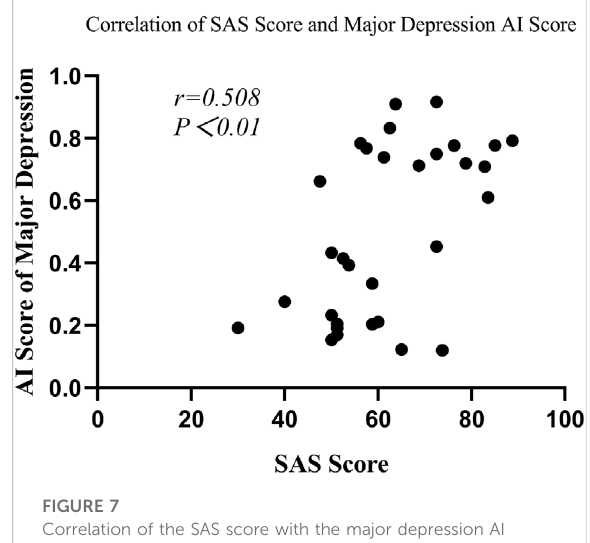
FIGURE 6 Correlation of the SDS score with the major depression AI score.